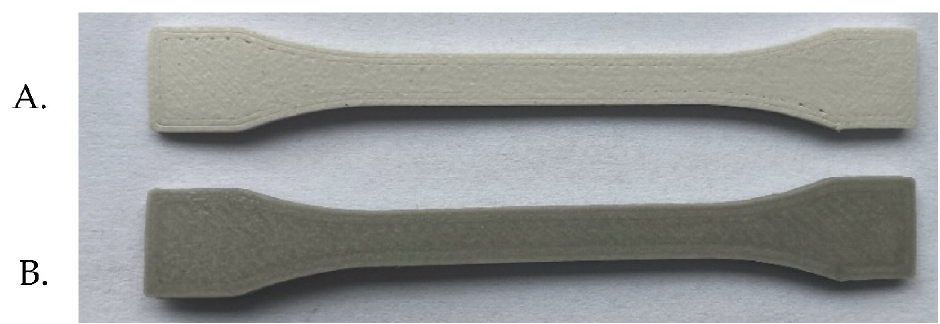
Figure 15. Samples for strength tests: ( A ). PA12-ZrO 2 , ( B ). PA12-Al 2 O 3.